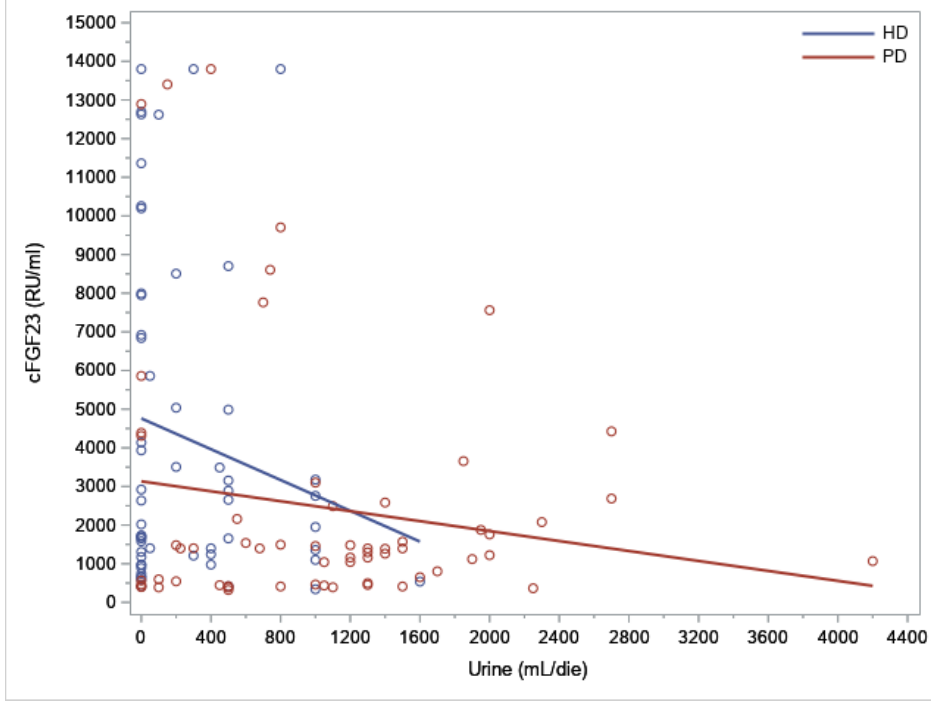
Figure 3. Scatter plot of the cFGF23 levels and residual urine output (UO) volume with the regression line considering the type of dialysis treatment (HD and